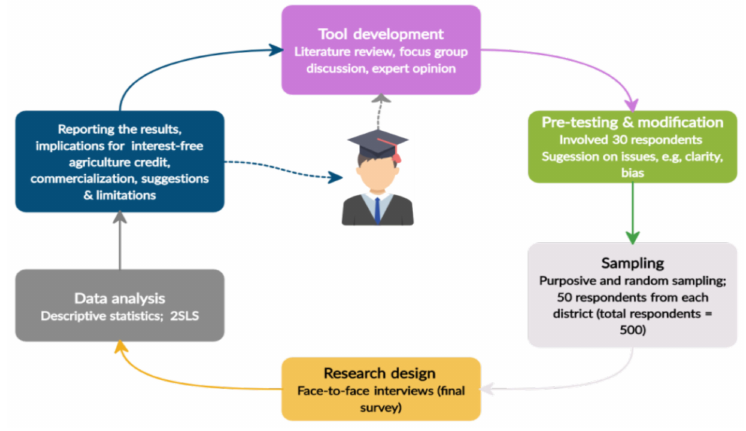
Figure 3. Stages of the research